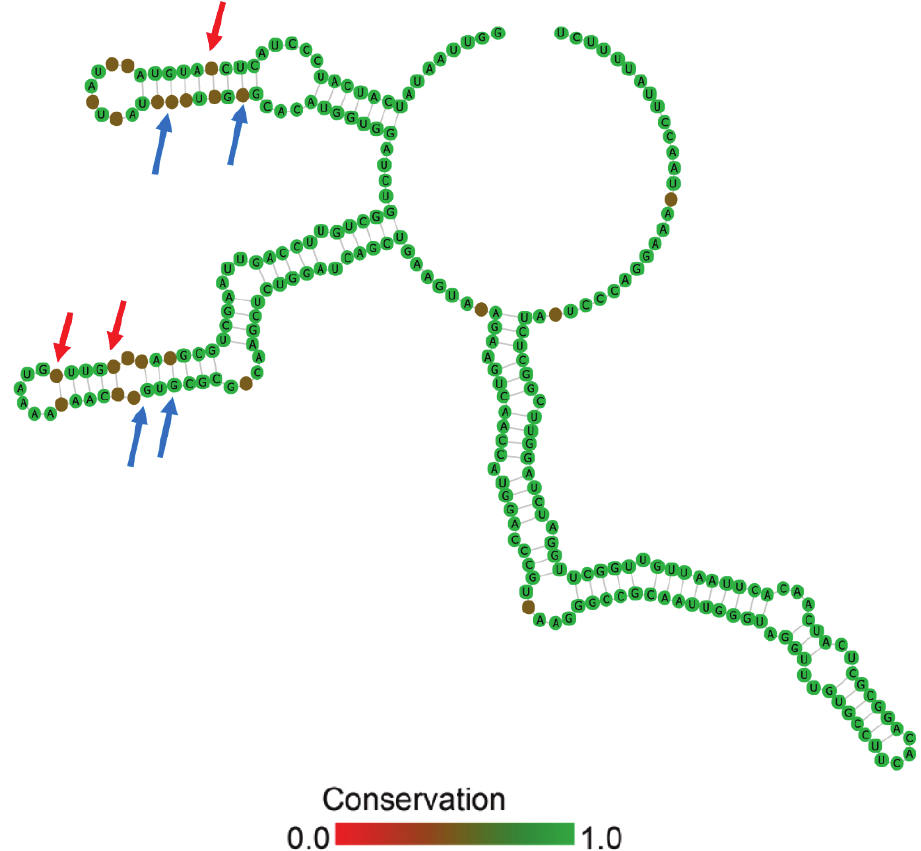
Figure 13. The ITS2 secondary structure between the two strains in Spongiosarcinopsis . The darker the color, the more significant the variation. Differences between the two species have been indicated by arrows in the figure, red for CBCs and blue for